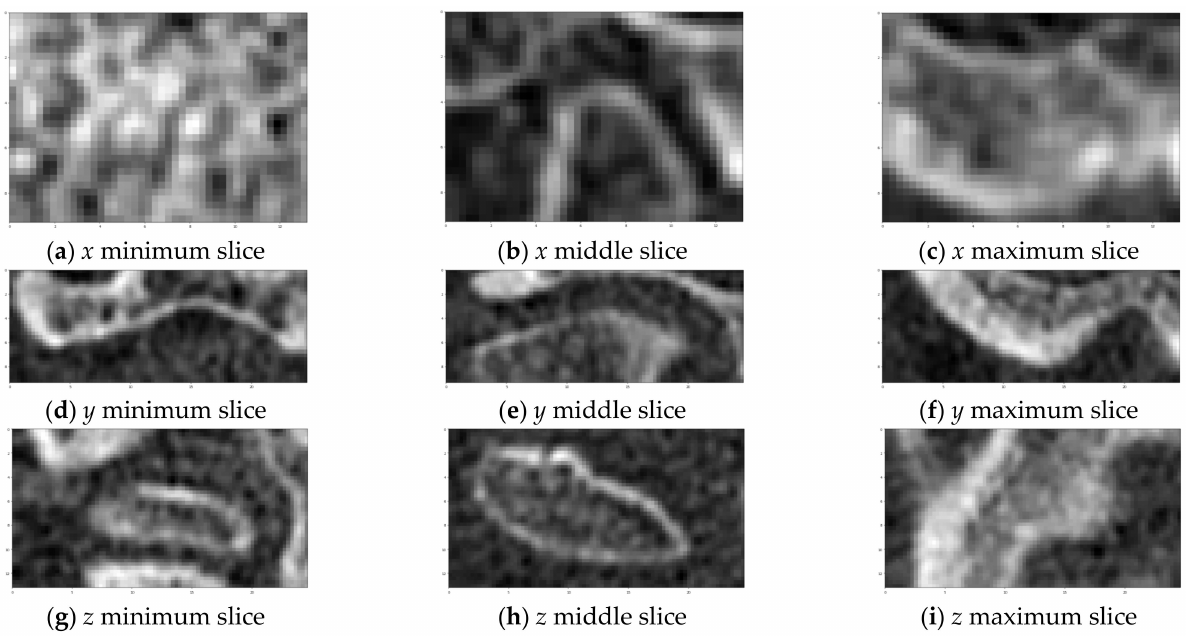
Figure 3. Example of VOI selection. The slices were taken on both sides and in the middle of VOI in each